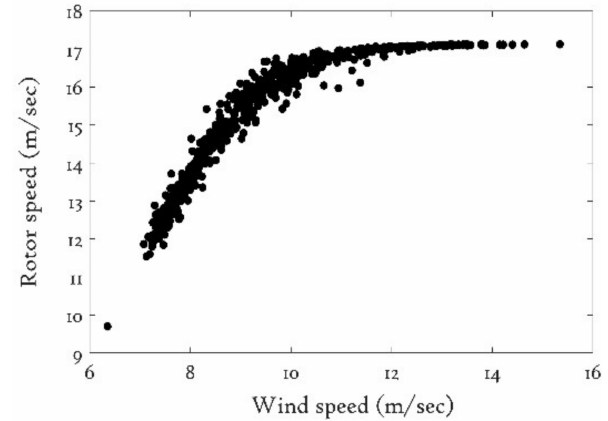
Figure 7. Filtered rotor speed